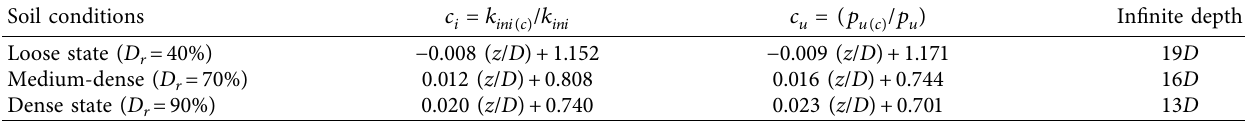
Table 6: Cyclic loading factors for cyclic p - y